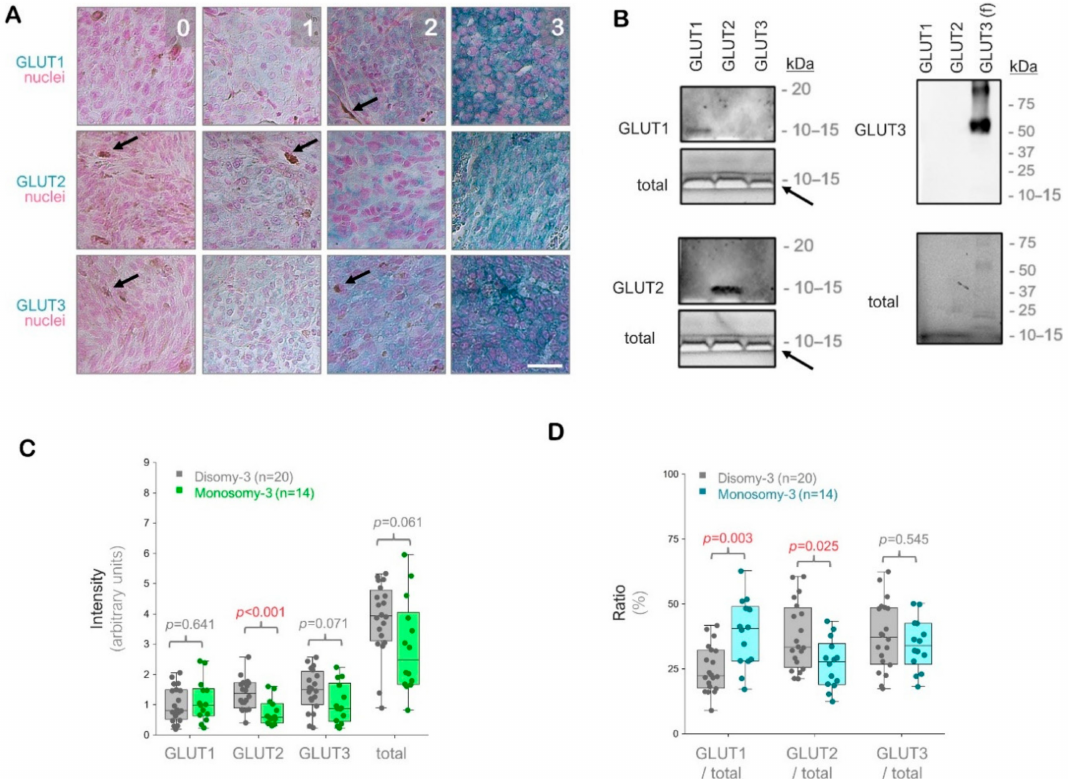
Figure 1. Analysis of the glucose transporters GLUT1-3 in the primary uveal melanomas (UMs) by immunohistochemistry. ( A ) Representative images from the immunostainings for GLUT1-3. Signal detection was performed using the horseradish peroxidase-green substrate, which generates a blue-green reaction product. The nuclei were counterstained with nuclear fast red. The strength of the immunohistochemical reaction within a circumscribed area was graded using a scale of 0–3 (0: negative. 1: weak. 2: intermediate. 3: strong). The mean intensity of the entire tumor area was determined by a semiquantitative approach as described in the Methods section. Images were acquired at an original magnification of 200 × . Arrows indicate the pigmented regions. Scale bar = 25 µ m. ( B ) Immunoblots with GLUT1-3 peptides or full-length recombinant human GLUT3 protein (f), demonstrating the specificity of the antibodies used. The total protein amount in the wells was detected by the stain-free imaging of gels after ultraviolet-activation. The white bands (arrows) correspond to the bromophenol blue dye in the loading bu ff er, which has not migrated out of the gels. kDa: Kilodalton. ( C ) Quantification of the GLUT1, GLUT2, and GLUT3 intensities in the primary UMs with regard to the monosomy-3 status. The sum of the GLUT1-3 intensities was also presented as “total”. p -values were determined by the Mann-Whitney U test. ( D ) Ratios of GLUT1, GLUT2, and GLUT3 to the total GLUT1-3 levels in the primary UMs with respect to the monosomy-3 status. p -values were analyzed by the Mann-Whitney U test. The significant p -values ( < 0.05) in ( C , D ) were stated in